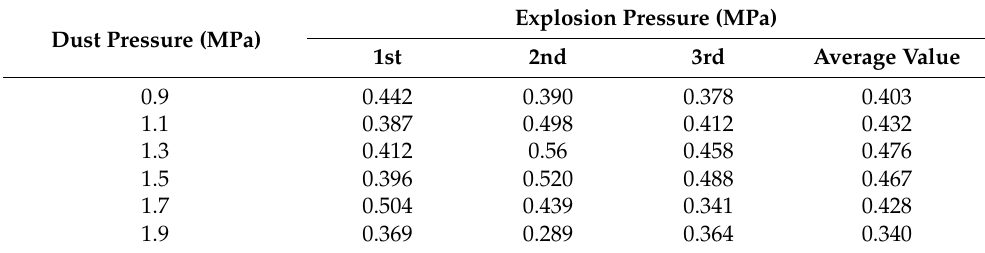
Table 3. Explosion pressure of cassava dust under different dusting pressures.